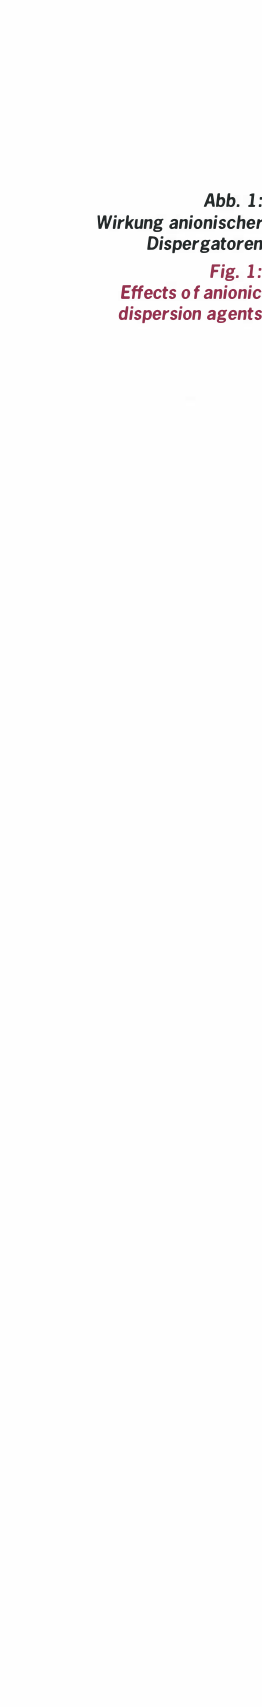
Fig. 2: Flow width of